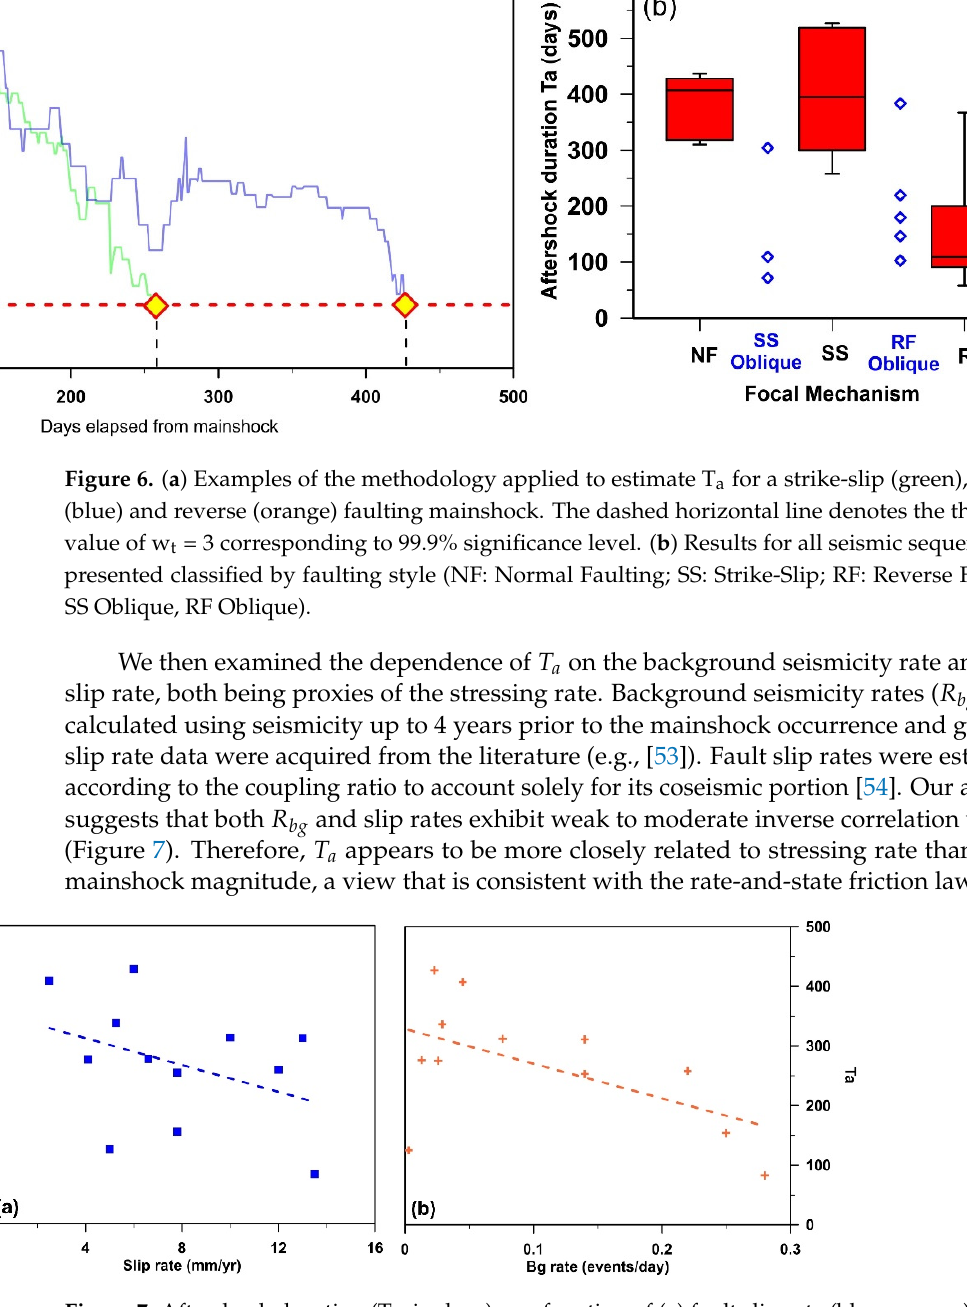
Figure 7. Aftershock duration (Ta, in days) as a function of ( a ) fault slip rate (blue squares) and ( b ) background seismicity rate (orange crosses). Data points are binned by mainshock magnitude.